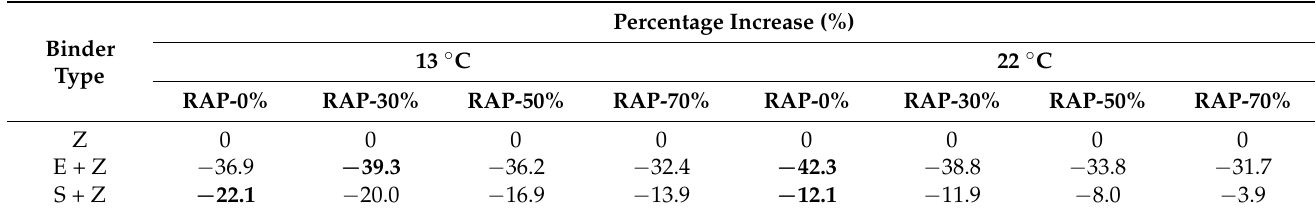
Table 10. Percentage increase in | G *| · sin δ caused by the WMA additive under the long-term aged condition.